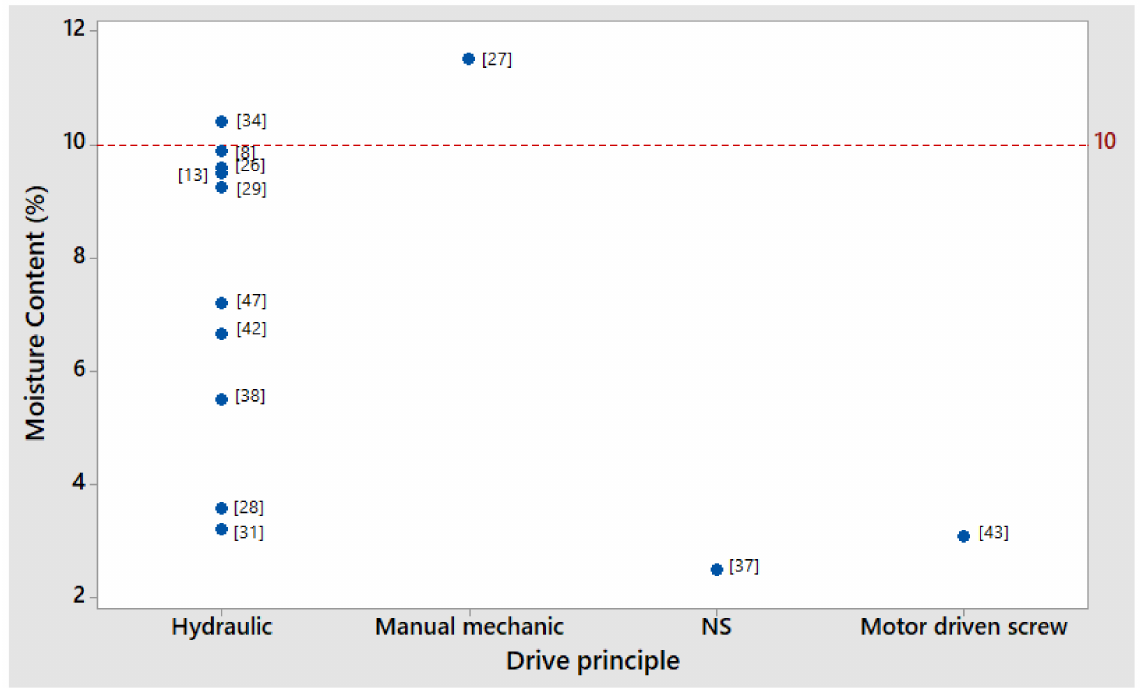
Figure 6. Relationship between individual values of moisture content (MC) with the principle of operation of briquetting machines.